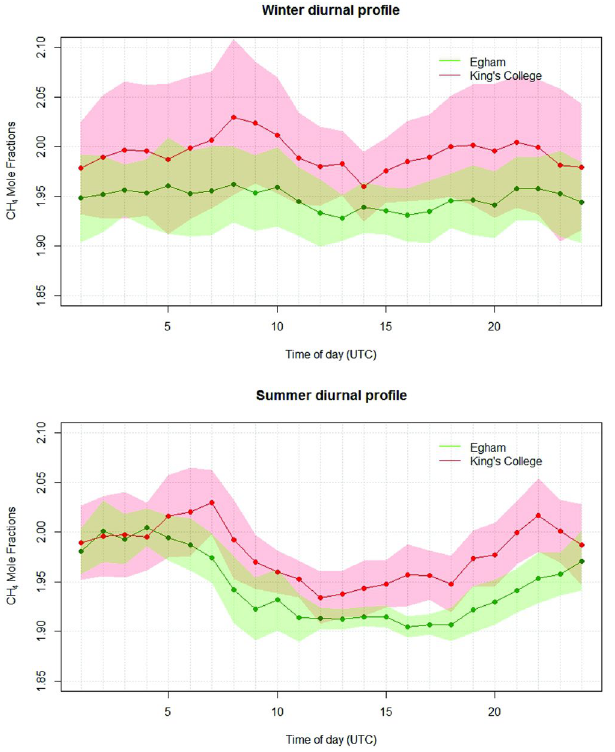
Figure 5. Median hourly diurnal cycle mole fractions in winter (2 nd December 2013 to 31 st Jan 2014) and summer (24 th July 2014 to 6 th August 2014) at KCL and Egham. Shading indicates the interquartile